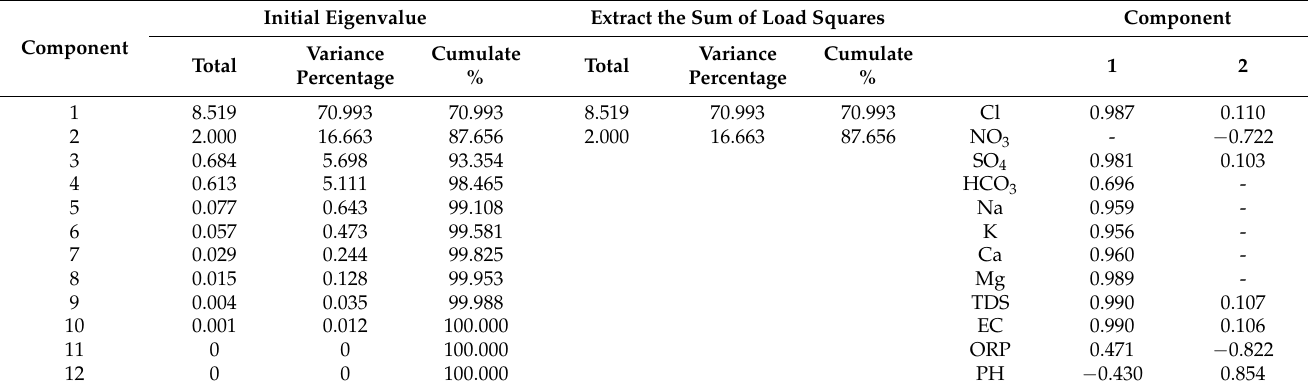
Table 3. Principal component eigenvalues and variance contribution rates and principal component load